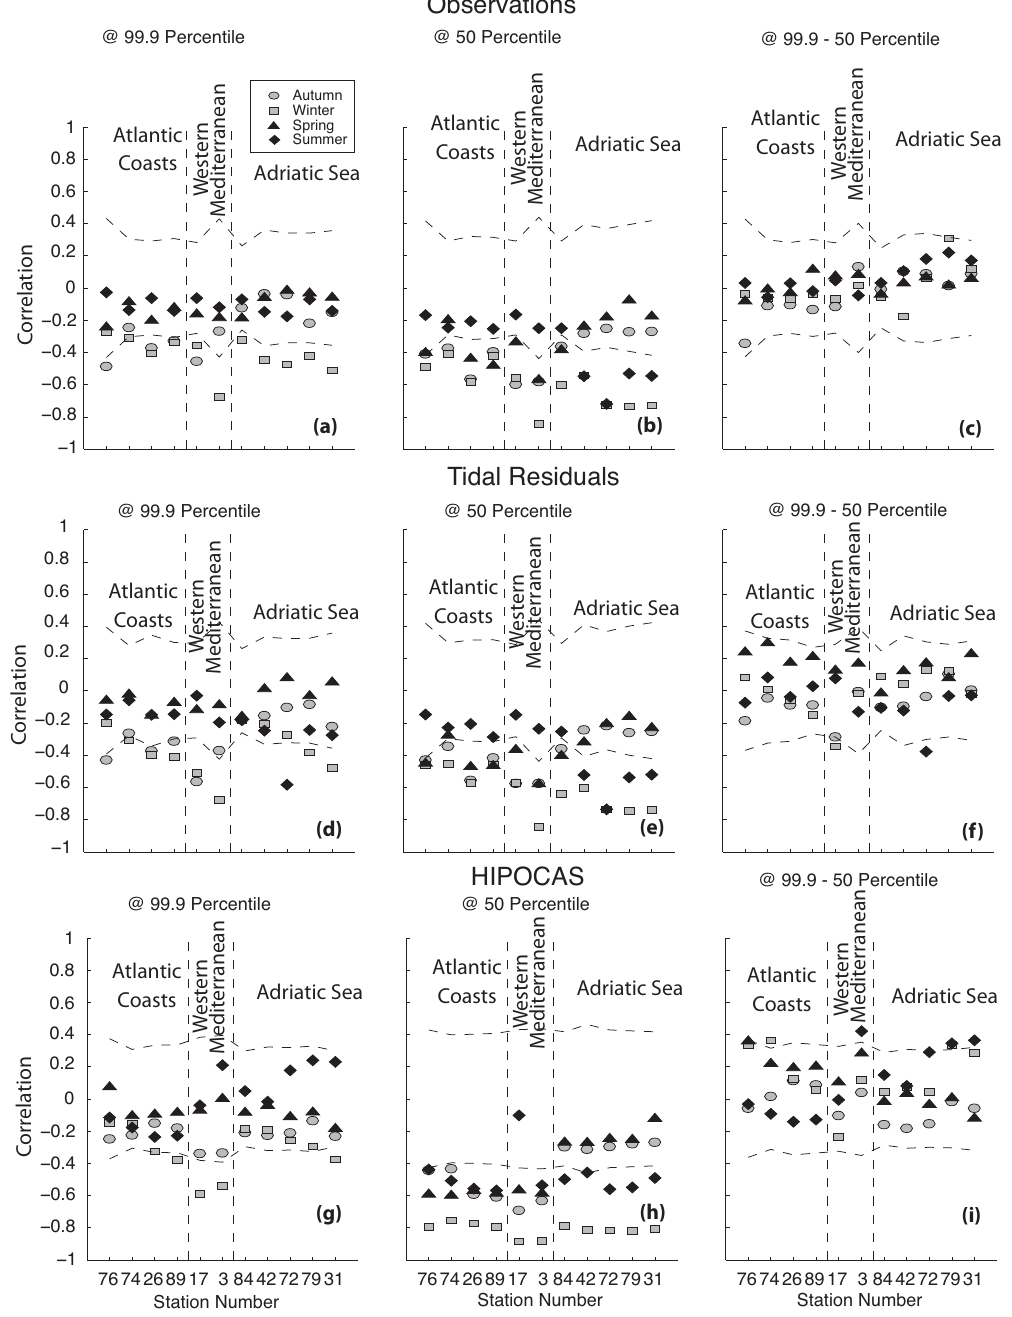
Figure 7. Seasonal correlations of the NAO index with the 99.9 percentile, 50 percentile and their differ- ence. (a-c) for the observed values; (d-f) for the tidal residuals; (g-i) for the model values. Each of the seasonal correlation coefficients has an associated value in order to be significant at 95% level. We have plotted the highest of the four values as giving the most conservative estimate for the level of significance.